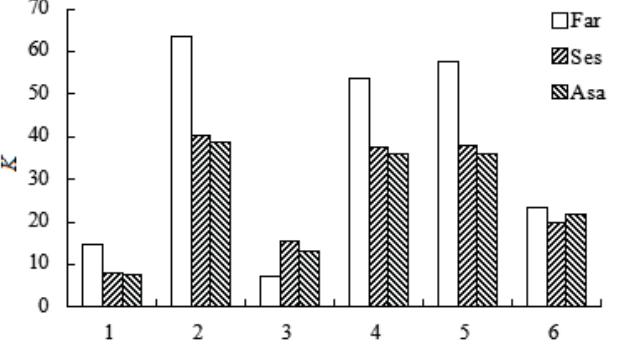
Figure 3. Effect of different aqueous two-phase systems on the partition coefficient ( K ) of three lignans. 1: 24% (NH 4 ) 2 SO 4 /20% ethanol; 2: 24% (NH 4 ) 2 SO 4 /20% n- propyl alcohol; 3: 22% K 2 HPO 4 /24% ethanol; 4: 22% K 2 HPO 4 /24% n- propyl alcohol; 5: 24% citrate/20% n- propyl alcohol; 6: 24% citrate/20%